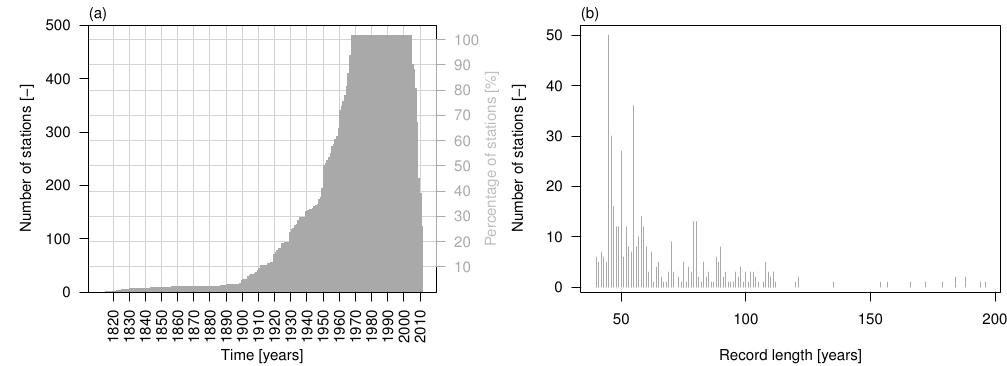
Figure 2. ( a ) Time series of the number and percentage of stations available in a given year (out of 473); ( b ) Histogram of the record length for the 473